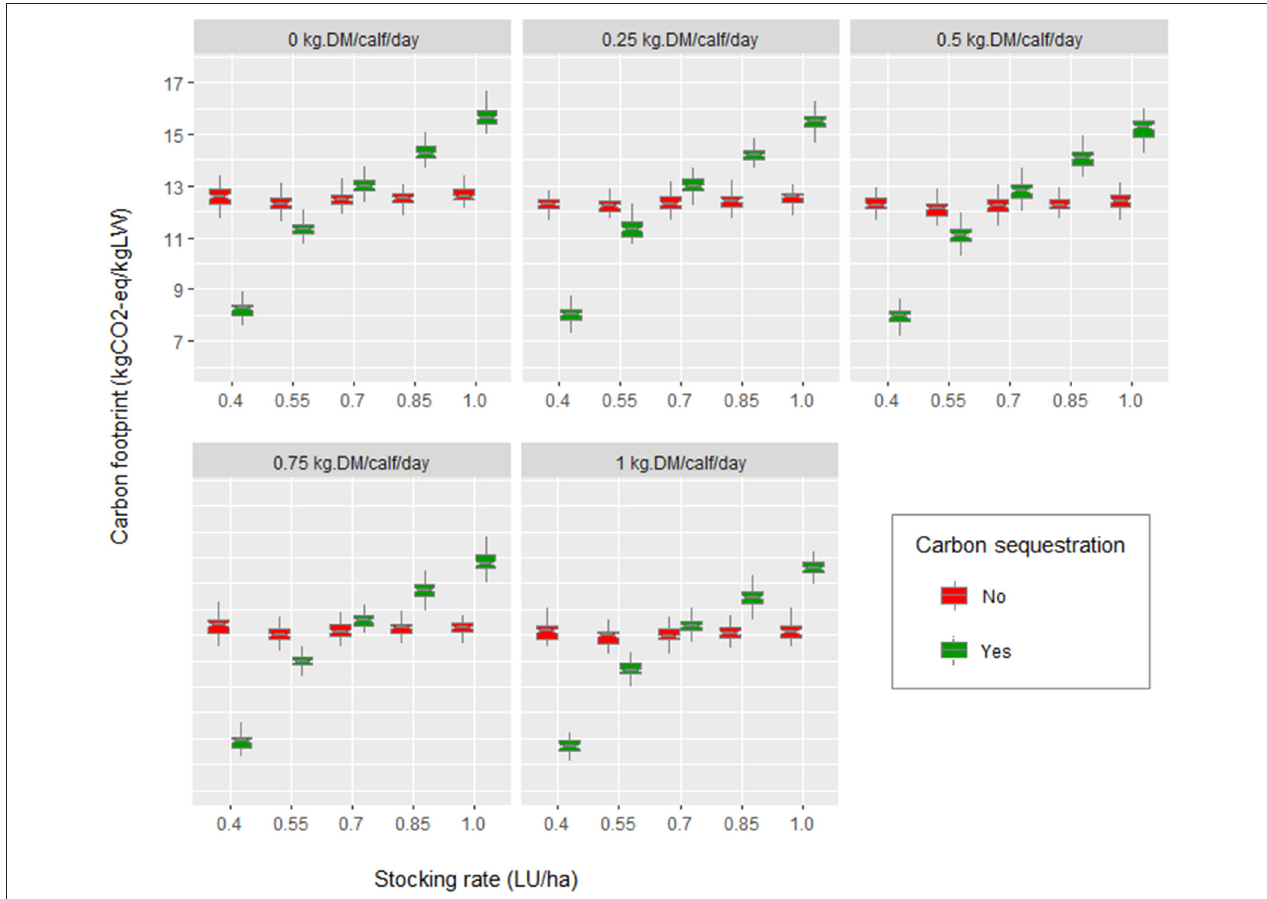
FIGURE 3 | Effect of stocking rate (0.4, 0.55, 0.7, 0.85, and 1 LU/ha), calf supplementation (creep feeding), and carbon sequestration on carbon footprint